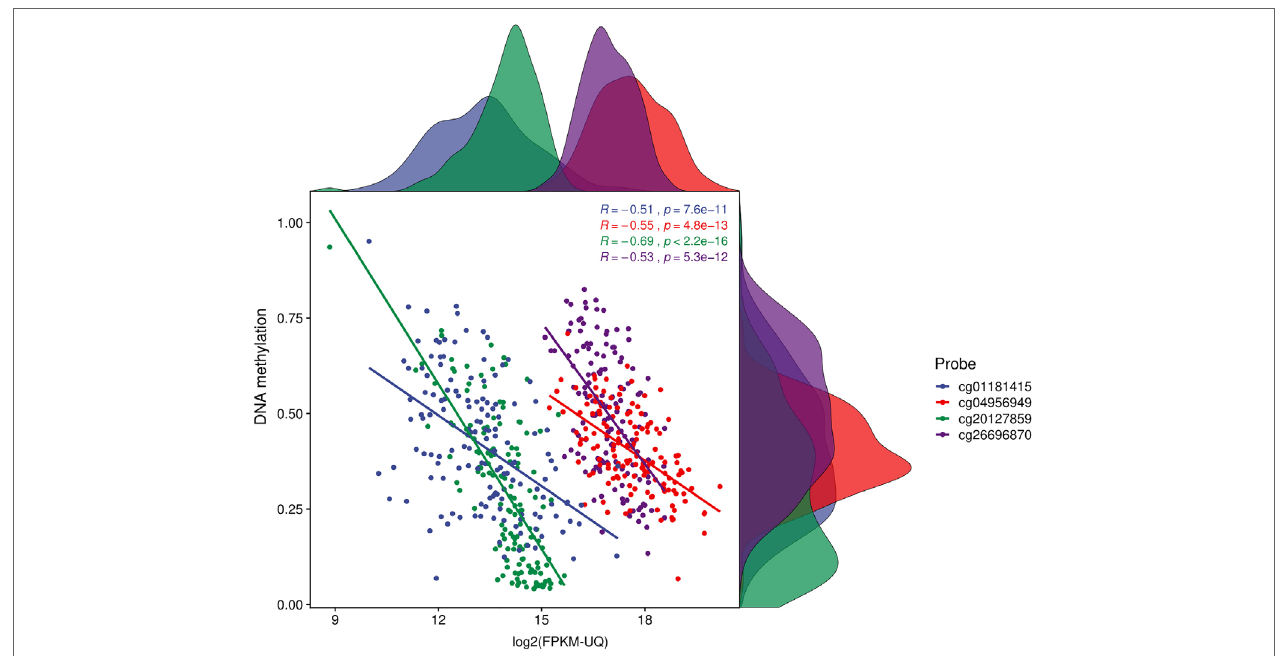
FIGURE 3 | Correlation plot for survival associated CpGs. We used CpGs which have survival p < = 0.01 and Spearman correlation > 0.5 ( p -value < 0.005). This plot is for four promoter CpGs which are negatively correlated with genes expression and also strongly associated with patients’ survival. Distribution of DNA methylation and gene expression in PDAC patients on the right side and top